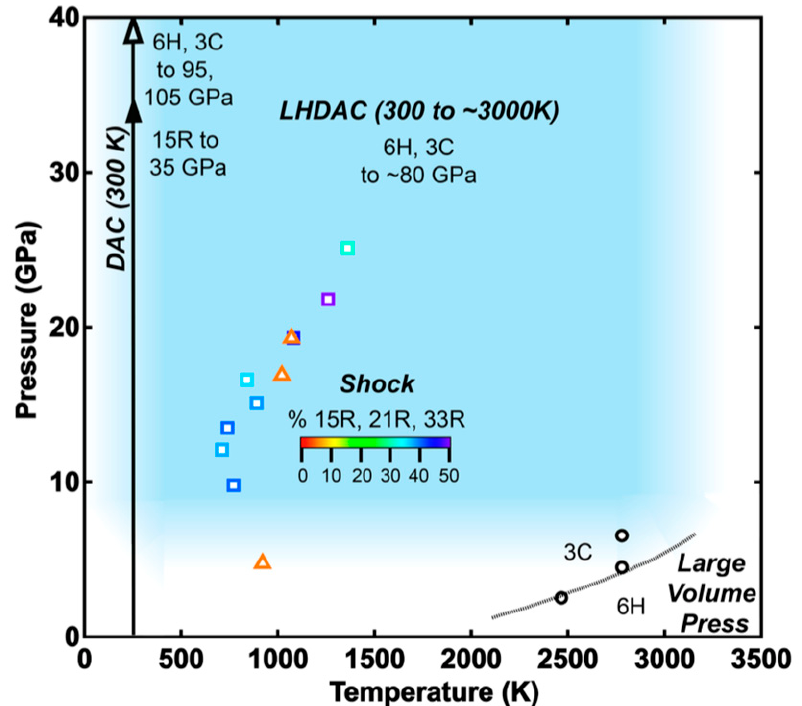
Figure 2. Compilation of experimental work on polytype transformations at pressure. DAC studies find that 15R remains under compression to at least 35 GPa at 300 K [22], 3C remains stable to 105 GPa at 300 K and 6H remains stable to 95 GPa at 300 K before transition to a dense, high-pressure rocksalt structure [25]. LHDAC experiments find that both 6H and 3C remain in experiments covering conditions of ~10–80 GPa and ~3000 K (shown in blue) before transition to the rocksalt structure [18,23,24,27,28]. Shock experiments up to 25 GPa and ~2000 K find an increase in the proportion of rhombohedral and cubic phases at high P-T and a decrease in hexagonal phases [16]. Rainbow colored shock data indicate the proportion of rhombohedral polytypes resulting from shock: 15R forming in the α -SiC sample (15% in starting sample), plotted with open squares; 21R and 33R forming in the β -SiC sample (0% in starting sample), plotted with open triangles. Multi-anvil, high pressure apparatus work finds that 3C transitions to 6H at high P-T over 2000 K [14]. The lack of clear boundaries between phases may indicate that either the kinetics of transition are sluggish or that the energy difference between polytypes is low at high